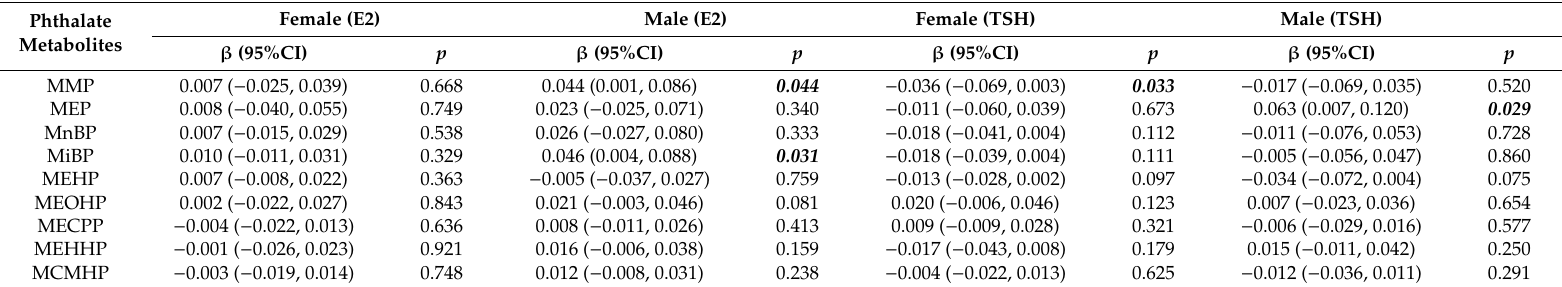
Table 7. Linear regression analysis of relationship between the phthalate metabolites and sex and thyroid hormones in cord blood. Phthalate